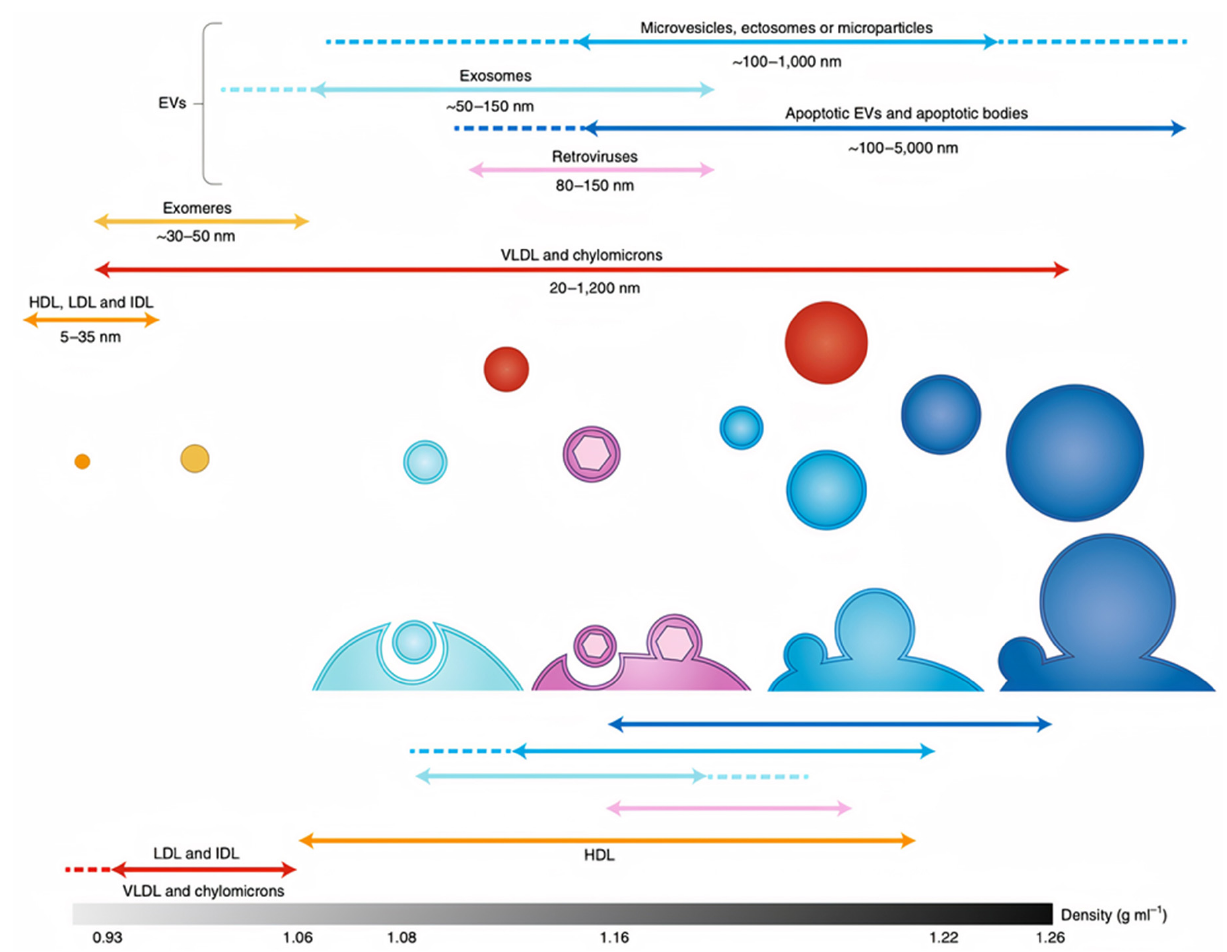
Figure 1. Size ranges of major types of membrane vesicles [33]. Figure reproduced with permission from Springer Nature.